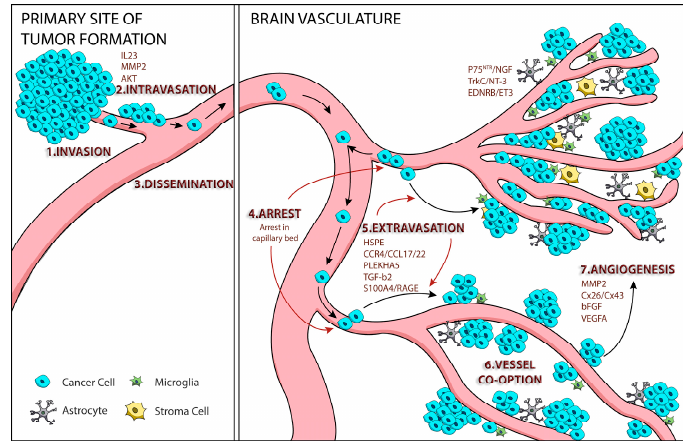
Figure 1. Steps and factors involved in melanoma metastasis to the brain.